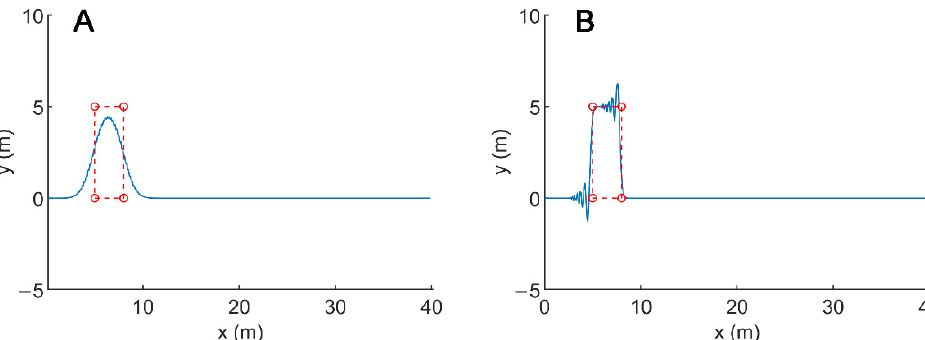
Figure 5. Numerical diffusion and numerical oscillation: ( A ) numerical diffusion obtained by the Lax–Friedrichs scheme, and ( B ) numerical oscillation obtained by the Lax–Wendroff scheme.